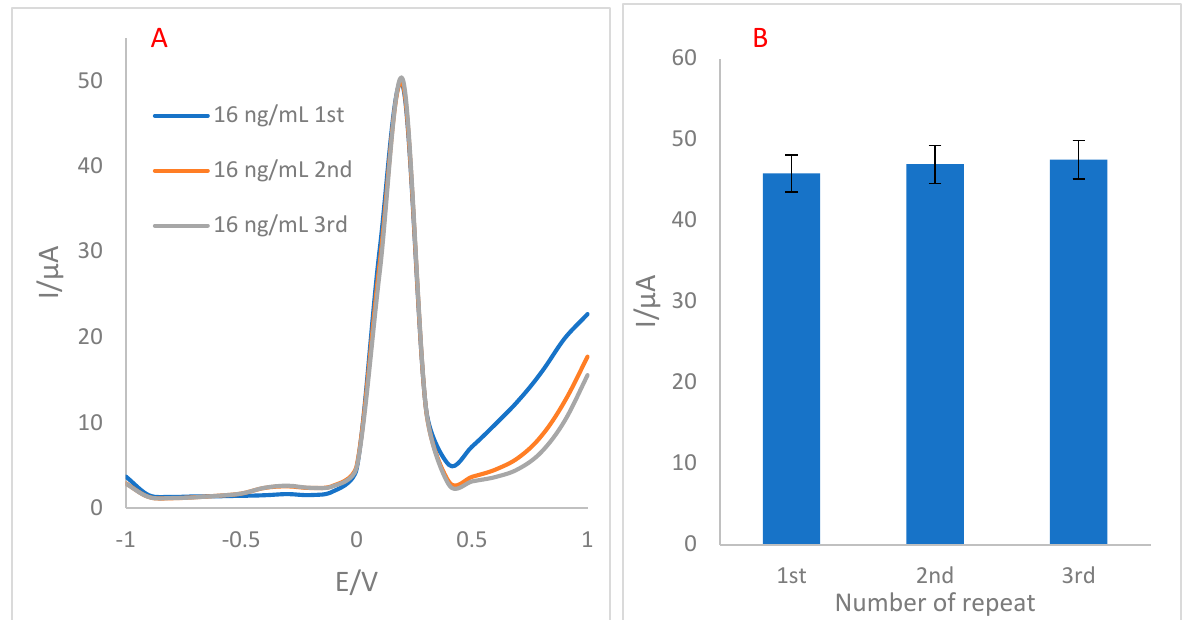
Figure 4. ( A ) DPV of GCE- β -CD–KCC-1-NH-CS 2 -Ab-BSA in the presence of 16 ng/mL α -syn in three repetitions. The supporting electrolyte was 0.05 M solution [Fe (CN) 6 ] 3 − /4 − /KCl; the potential range was from -1 to 1. ( B ) Comparison of 1st, 2nd, and 3rd peak currents (SD = 2.13, n = 4).